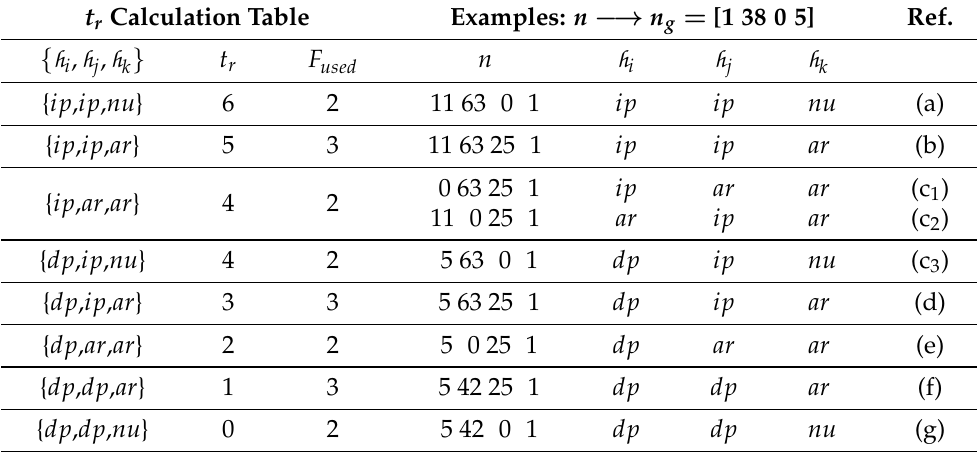
Table 1. Estimated number of reconfiguration t r in function of the non-ordered set { h i , h j , h k } for a path n −→ n g , considering a 2-fingered grasp n g and some examples considering the final node n g = [ 1 38 0 5 ]